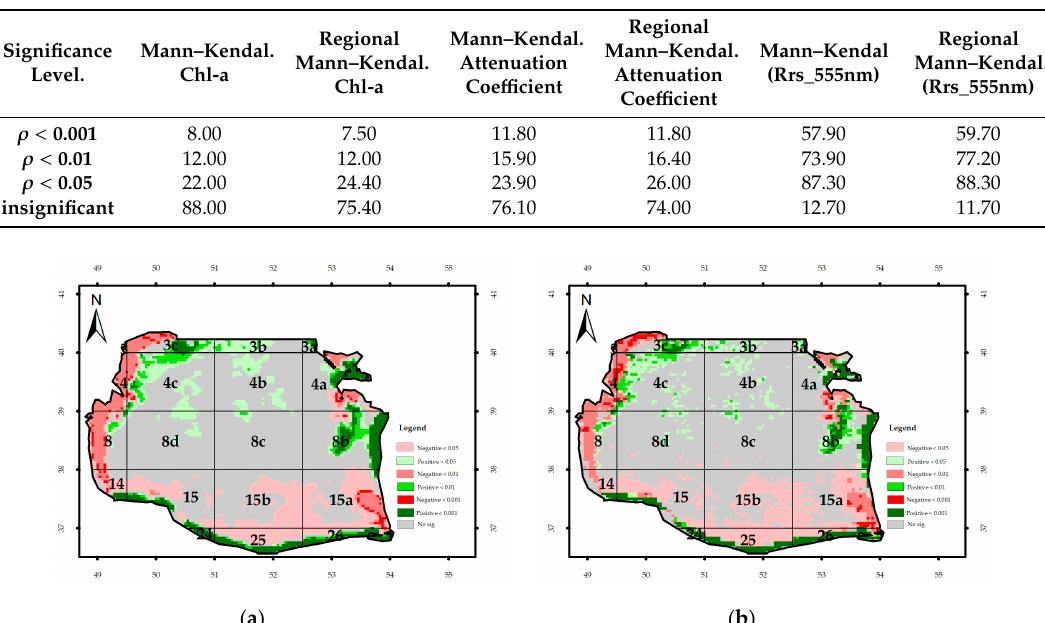
( a ) ( b ) Figure A5. Significance of monthly trend of Rrs_555nm: ( a ) Regional Mann–Kendal and ( b ) Mann– Kendal. ( a ) ( b ) Figure A6. Monthly mean values for the NAO index ( a ) and ENSO index ( b ) obtained from database Http://www.Esrl.Noaa.Gov/psd/data/correlation/oni. Data